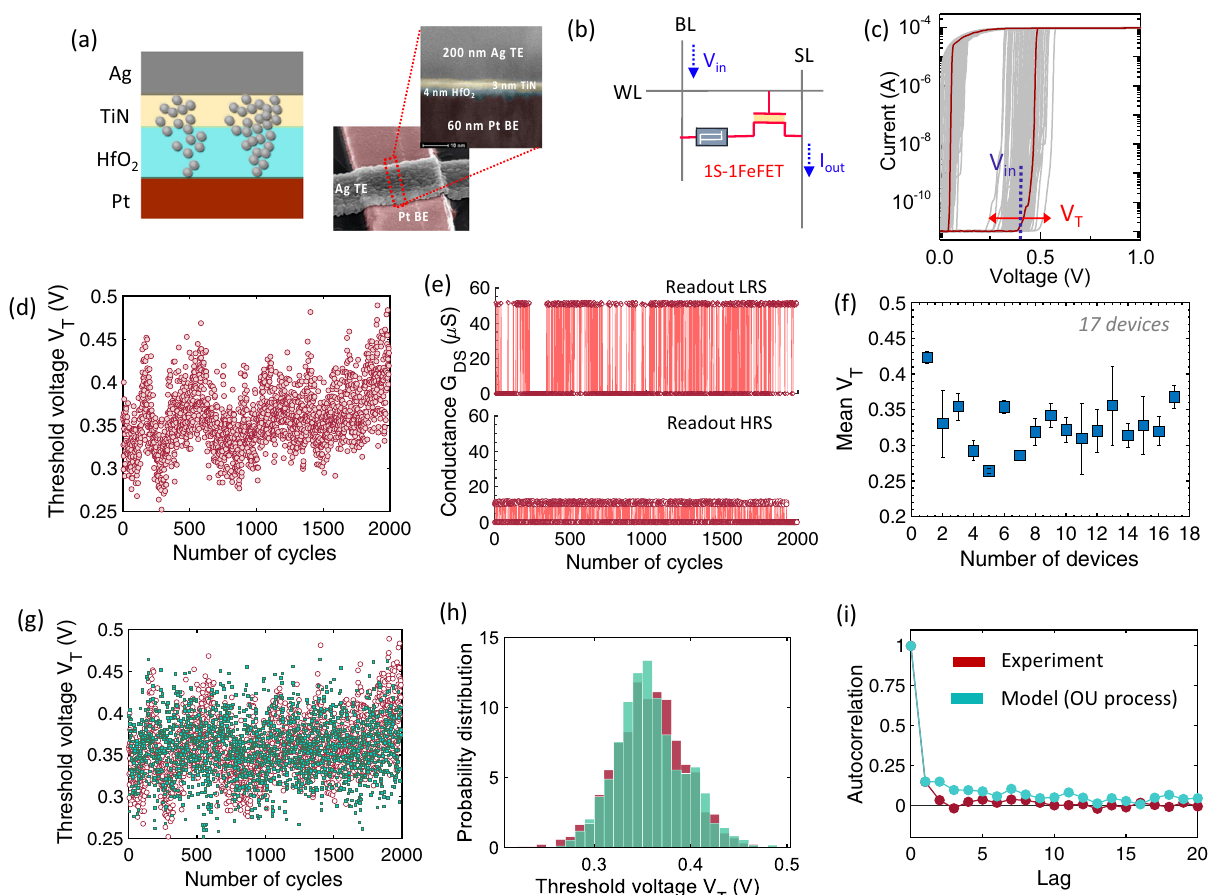
Fig. 3 Introducing multiplicative noise through stochastic selector. a Schematic and TEM of a fabricated stack of [Ag/TiN/HfO 2 /Pt] with 3 nm TiN and 4 nm HfO 2 . b A stochastic synapse is realized by augmenting this stochastic selector in series with the FeFET-based analog weight cell. c Measured current-voltage characteristics showing abrupt electronic transition from insulating state to metallic state due to the formation of a continuous fi lament of Ag + atoms bridge the top and bottom electrodes. A wide window of variation in the threshold voltage V T that triggers the spontaneous formation of the Ag + fi lament is observed. The stochasticity can be exploited by applying the input voltage V V T . d Measured threshold voltage in within the variation window of the V T over multiple cycles. e Stochastically reading an LRS and an HRS of the FeFET through the stochastic selector. f Measured device-to-device variation across 17 selector devices. Error bar denotes standard deviation across the mean. g – i The stochasticity switching of the selector device is modeled using an Onrstein-Uhlenbeck (OU) Process. The model shows excellent agreement with the experimental data. WL word line, BL bit line, SL source line, V in input voltage, I out output current, LRS low resistance state, HRS high resistance